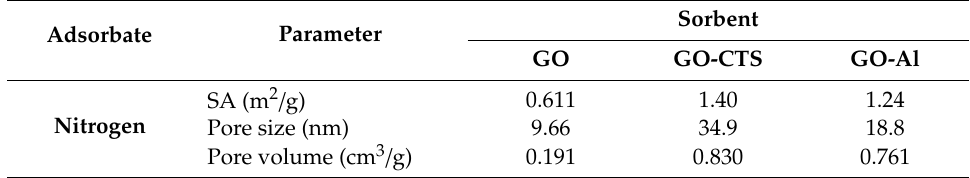
Table 3. BET adsorption isotherm parameters for GO and its composites with nitrogen at 77 K. Adsorbate Parameter